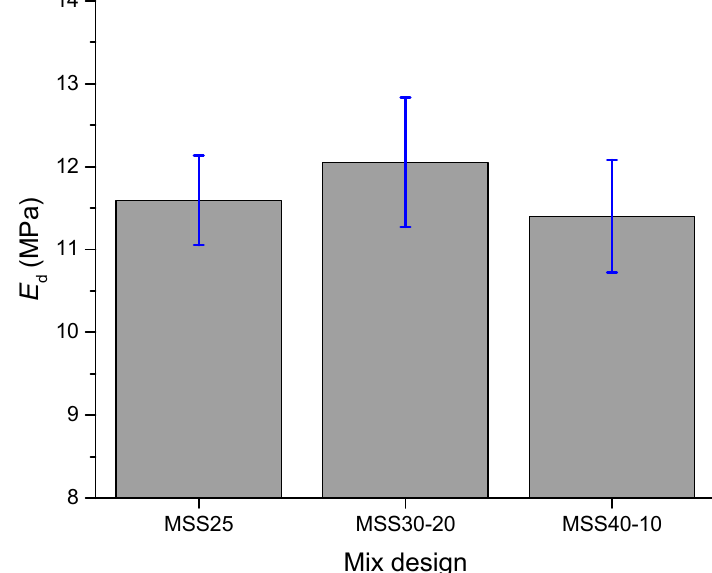
Figure 9. Results of mortar dynamic modulus of elasticity tests.